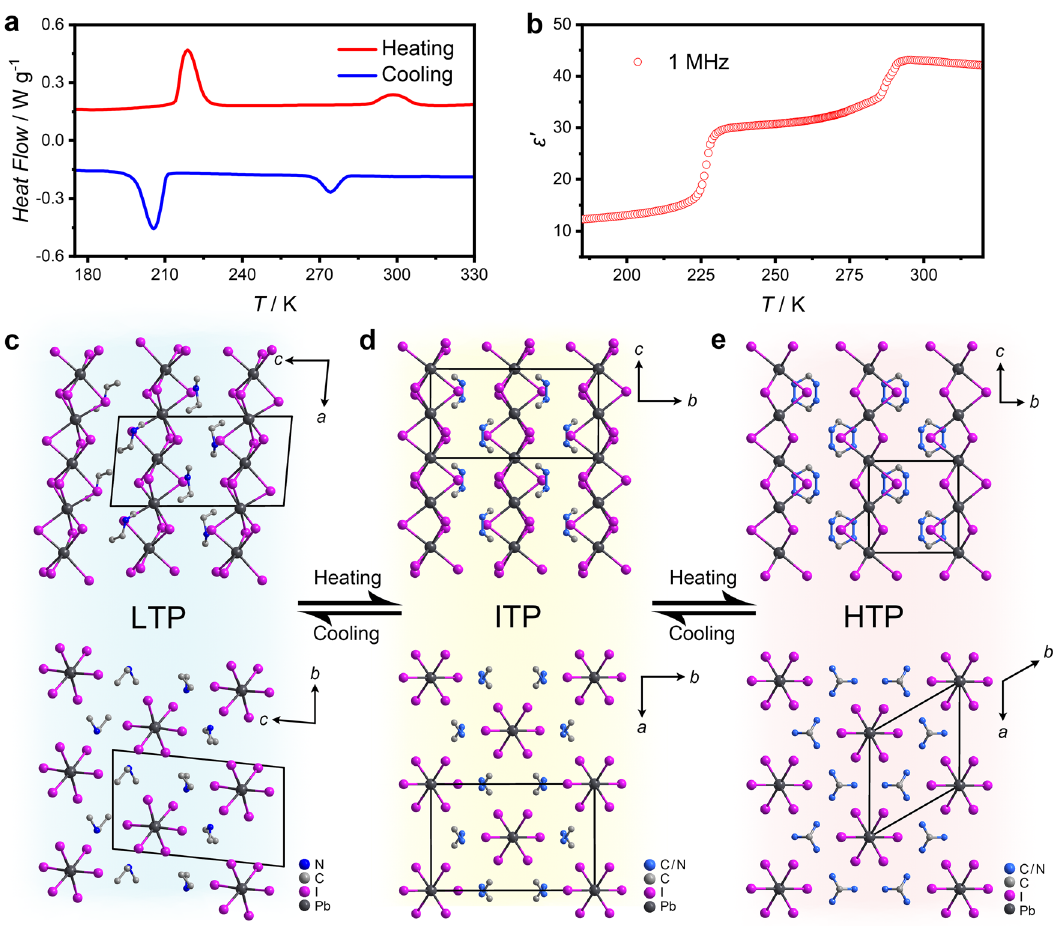
Fig. 2 | Phase transitions of 1. a DSC and b temperature-dependent dielectric constantcurvesof 1 . c – e SideandtopviewsofcrystalpackingalongPb − I1Dchains in the LTP, ITP, and HTP. LTP, ITP and HTP represents low/intermediate/high